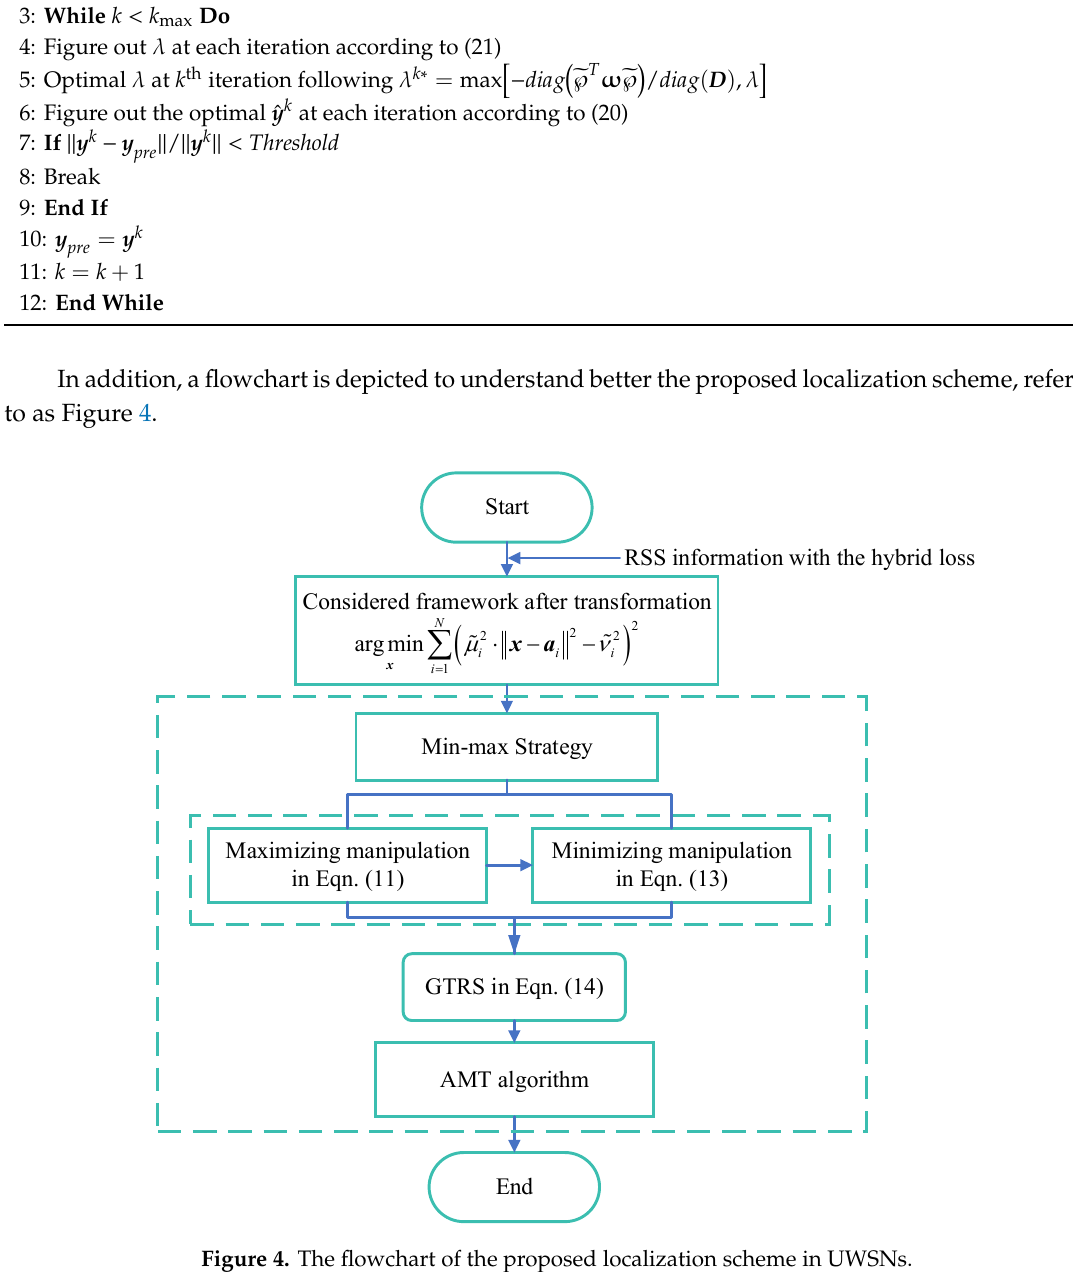
Figure 4. The flowchart of the proposed localization scheme in UWSNs.